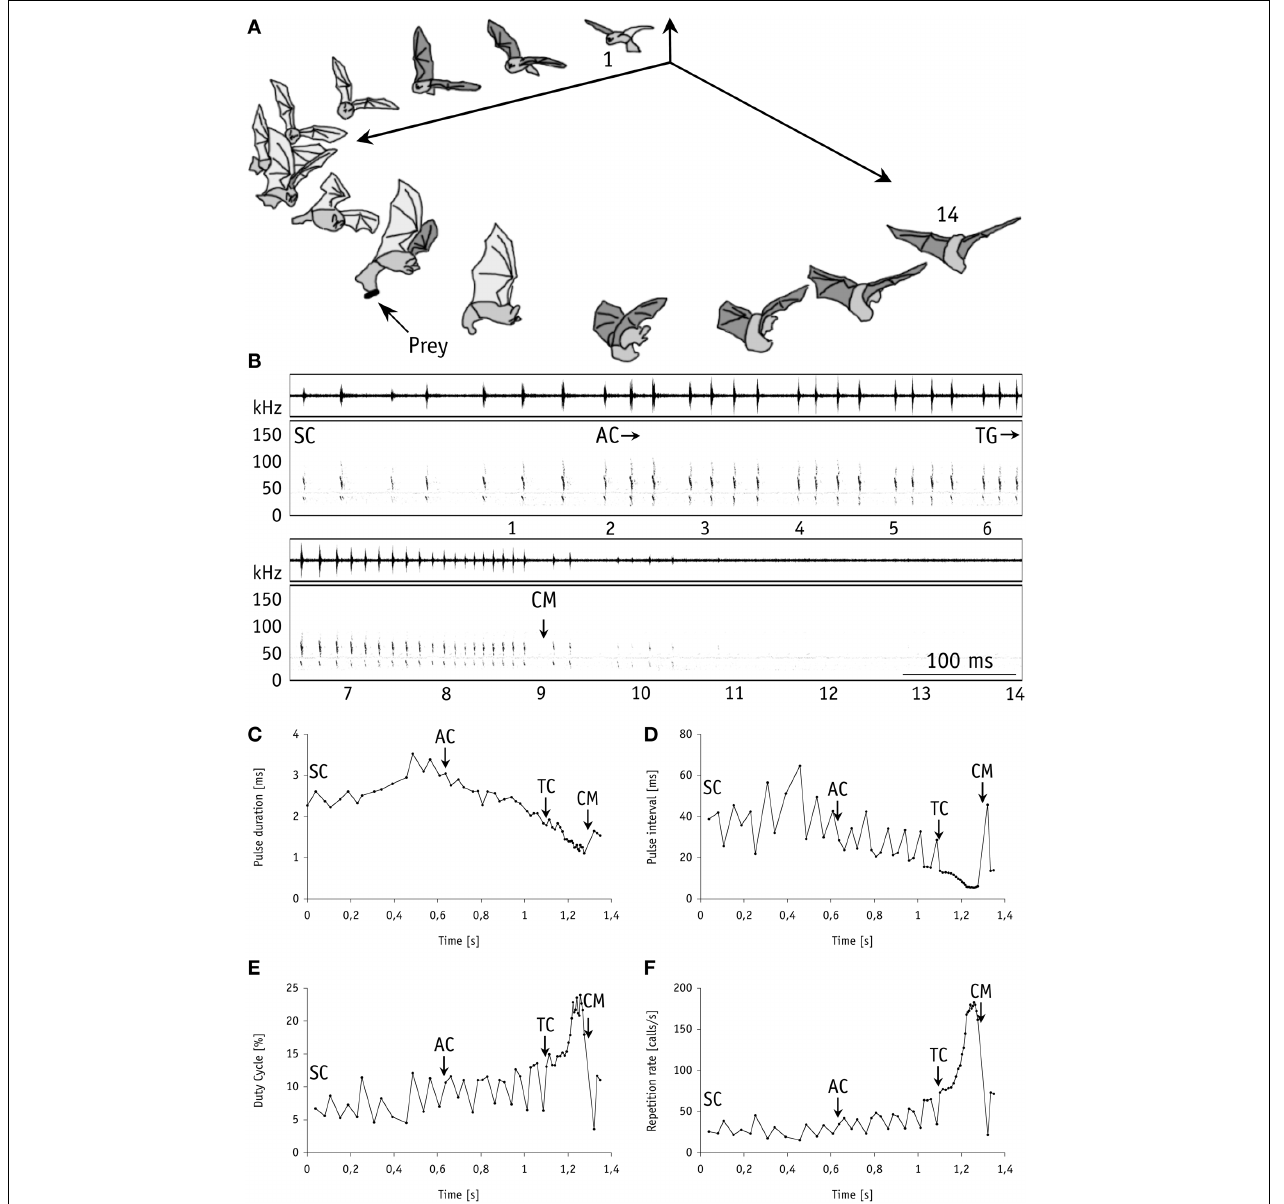
FIGURE 2 | Foraging behavior in 3-dimensional space synchronized with the corresponding echolocation sequence of M. macrophyllum approaching and capturing a mealworm suspended in the air above the water surface in the flight cage on BCI, Panamá. (A) 14 images of the bat (temporal resolution: 80ms). (B) Sonogram of the echolocation calls with